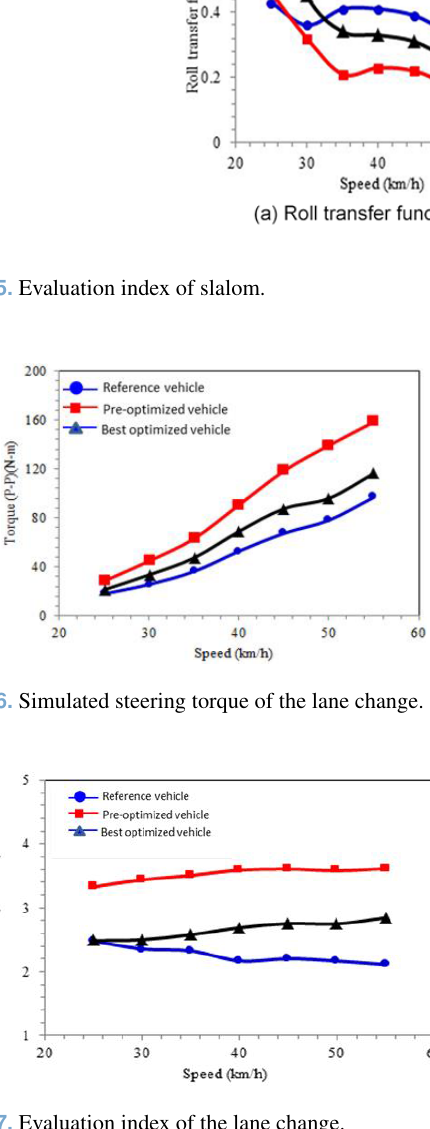
Figure 27. Evaluation index of the lane change.